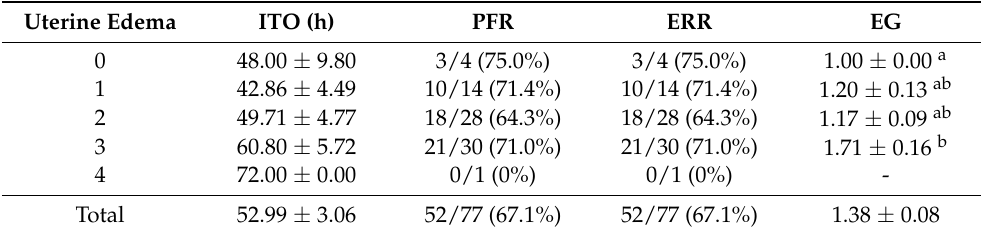
Total 52.99 ± 3.06 52/77 (67.1%) 1.38 ±